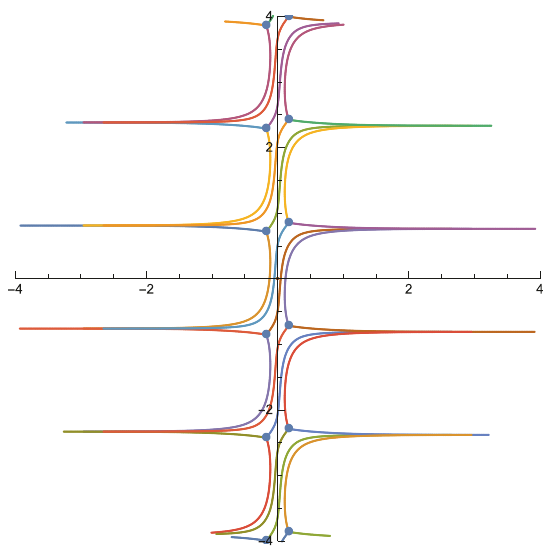
Figure 3 . The Stokes lines for Q ( τ ) = − (cosh 2 2 τ + 0 . 1 + 0 . 1 i )(1 + 0 . 1 i ) are shown on the complex τ plane. The double turning points and the degenerated Stokes lines are both split by introducing small parameters. Note however that imaginary η alone cannot solve all the degeneracy of this